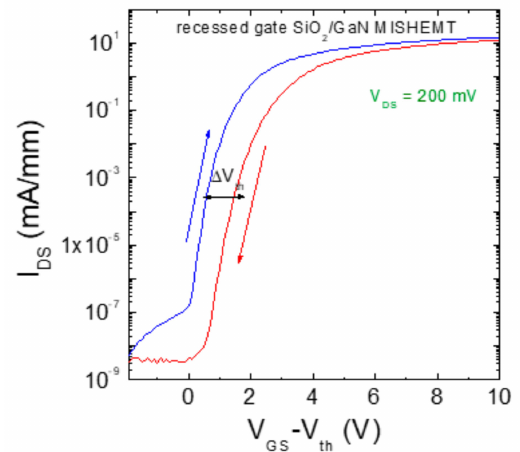
Figure 7. Transfer characteristics (I DS vs V G -V th ) acquired at V DS = 200 mV in a recessed gate MISHEMT under forward and reverse bias sweep, showing a shift of the threshold voltage ( ∆ V th